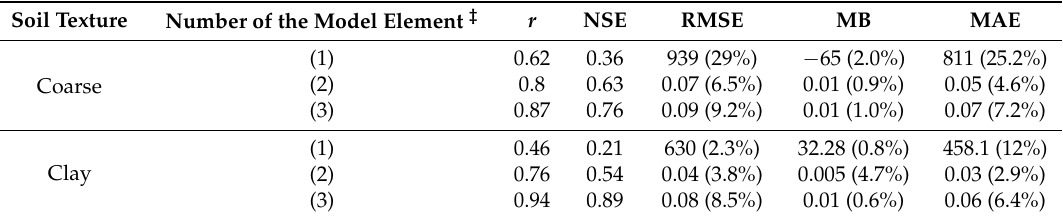
Table 2. Evaluation of the goodness-of-fit between the yield response models and the initial datasets † . Soil Texture